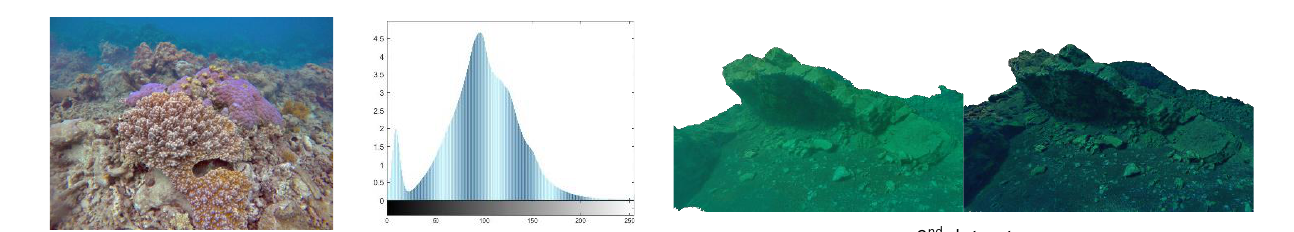
Figure 6. 3D reconstruction results, from initial ( left ) and enhanced images ( right ). 1 st dataset. 1 st row : textured mesh; 2 nd row : triangular mesh; 3 rd row : reconstruction detail from the shipwreck, where the improved geometry and texture are presented. 2 nd dataset. Details from the dykes.